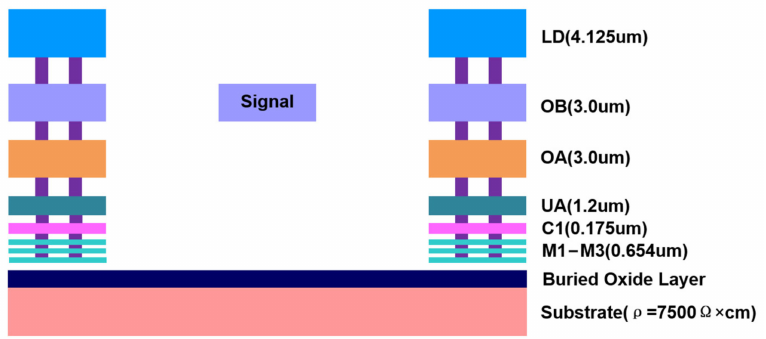
Figure 2. Cross-section view of GlobalFoundries 45 nm CMOS SOI metal